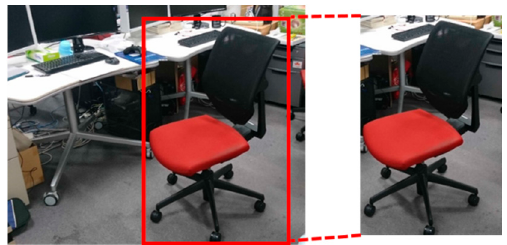
Figure 7. Example of bounding box in object recognition.